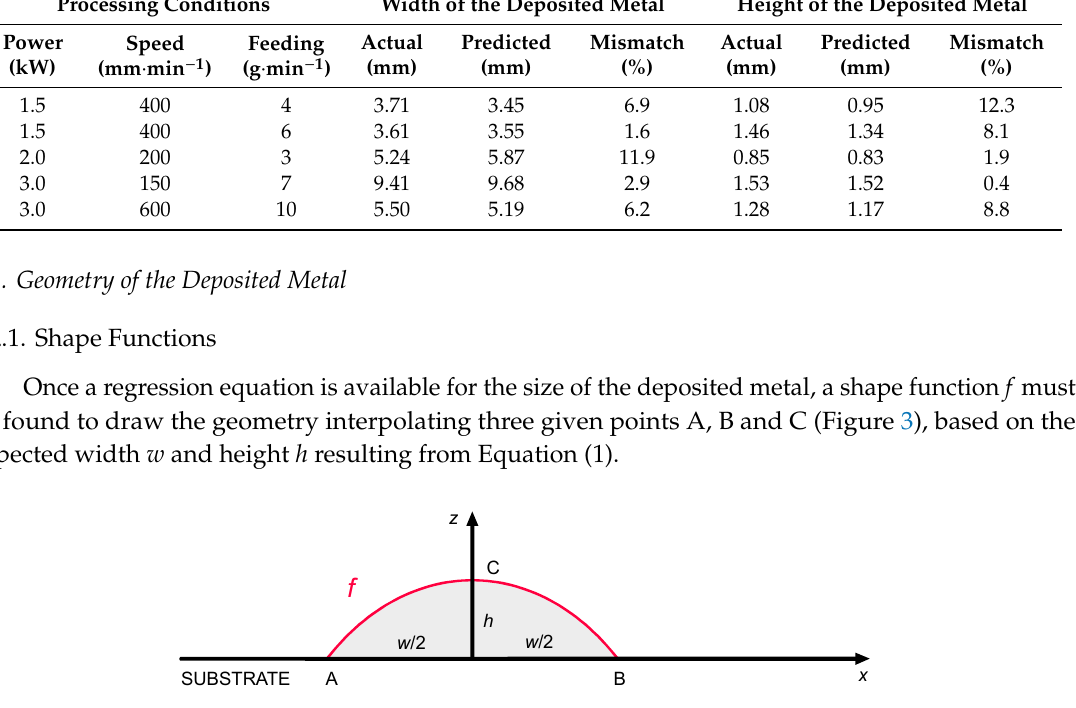
Figure 3. Shape function f for the deposited metal in the cross-section, single-track deposition.